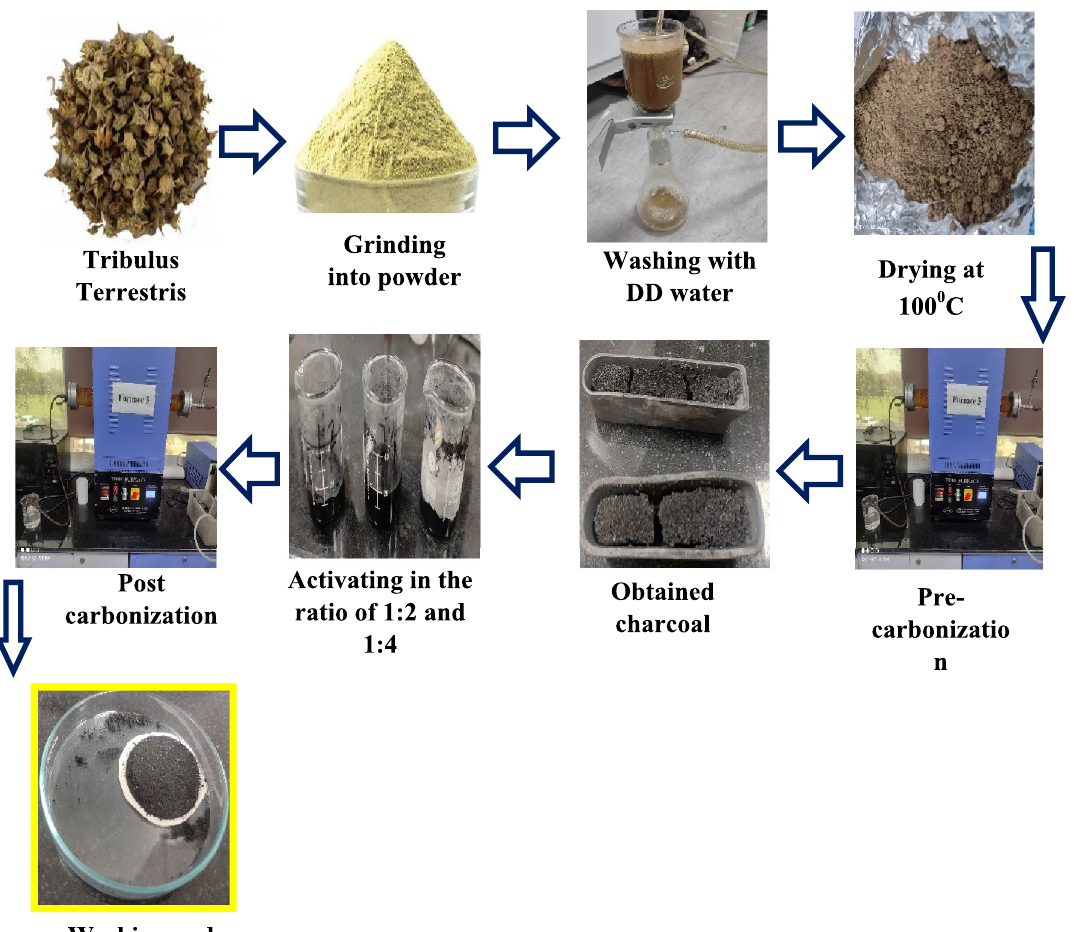
Fig. 1 Preparation of activated